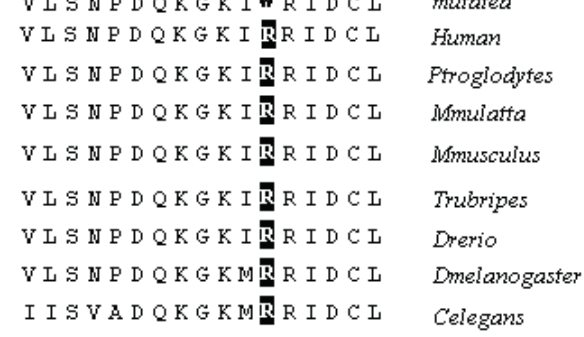
Fig. 6. Alignment of R123 amino acid in the NFIX protein showing conservation of the amino acid across